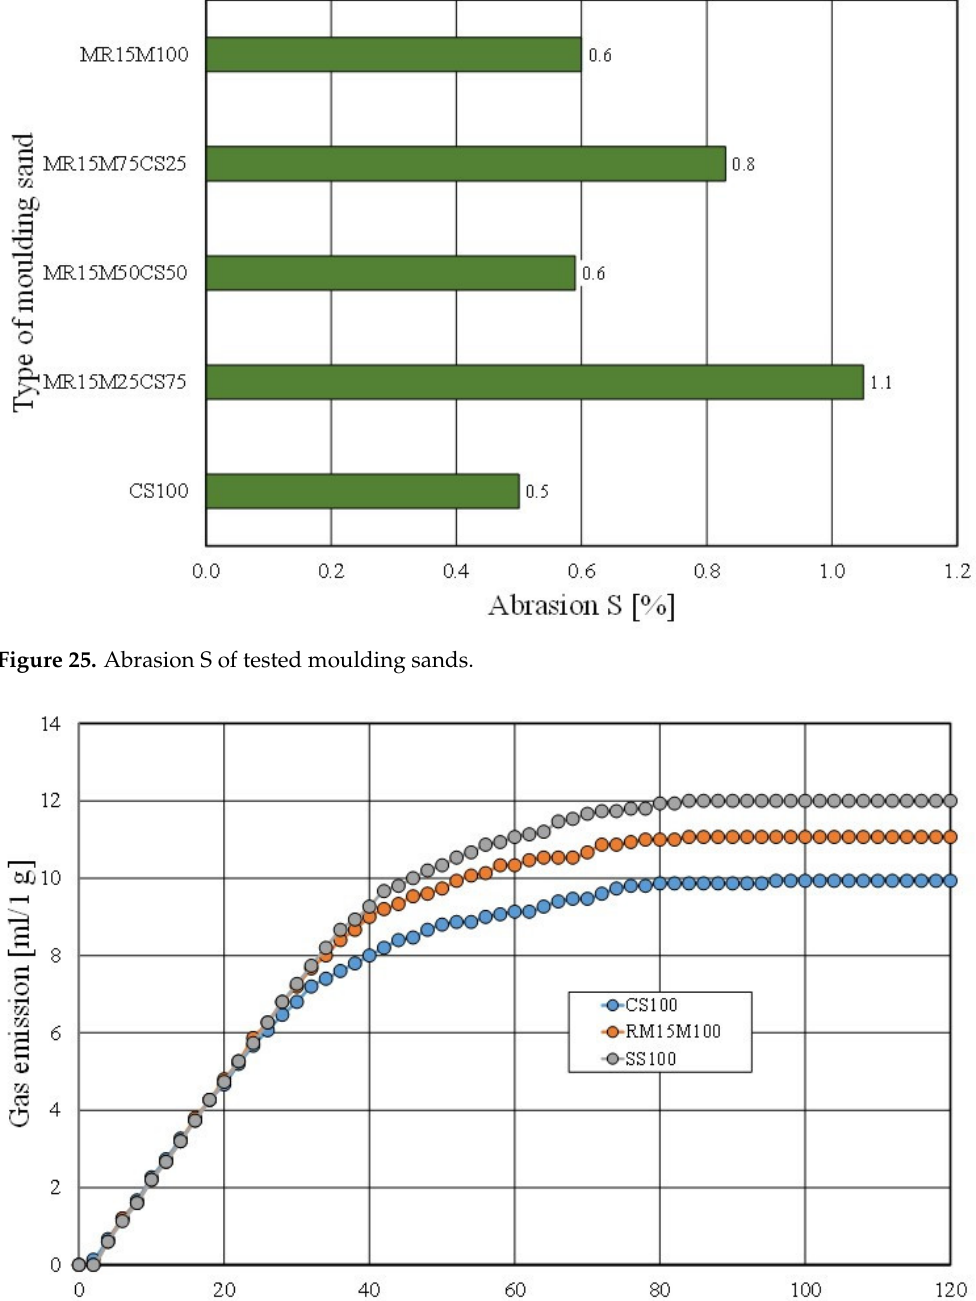
Figure 26. Comparison of gas emissivity of moulding